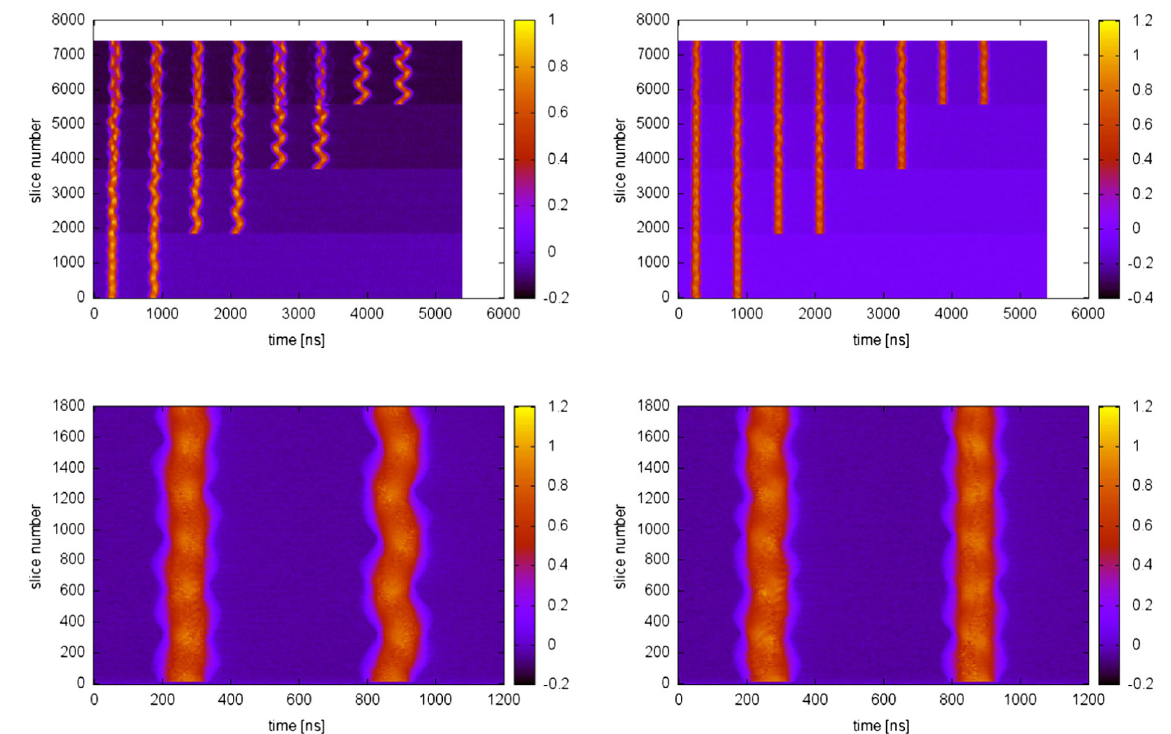
FIG. 12. Mountain plots of the WCM signals during the injection period (left) without and (right) with feedforward. Bottom plots are magnified ones just after K1 injection